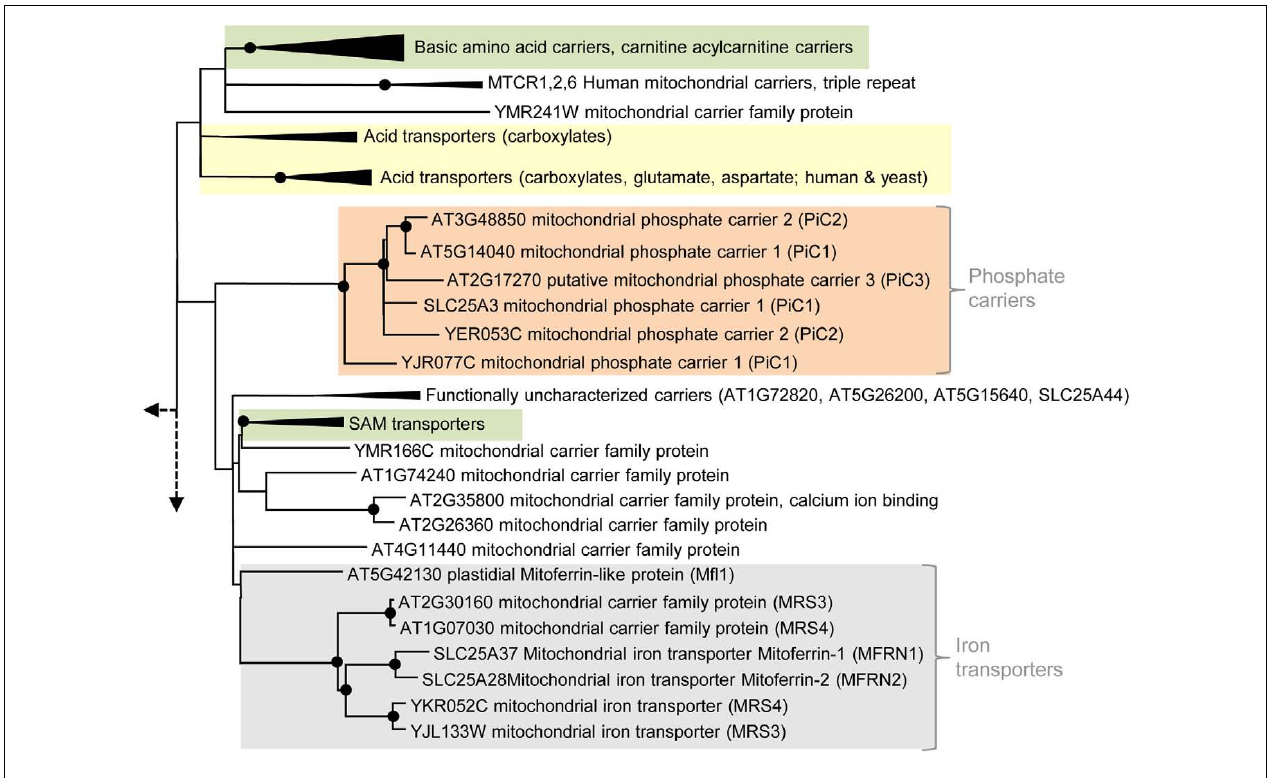
Nodes that are supported by bootstrap values (maximum likelihood and maximum parsimony, 1000 replications) higher than 70 are indicated by black